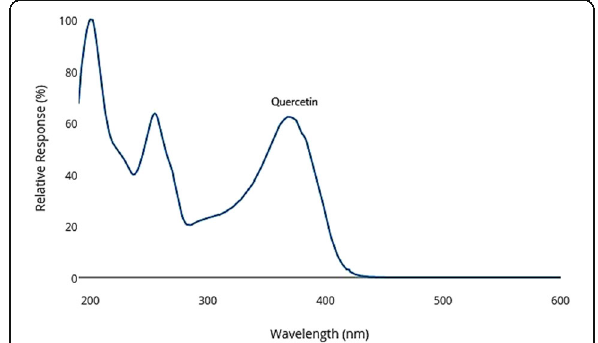
Fig. 5 Overlay UV absorption spectra of quercetin in peaks of standard and